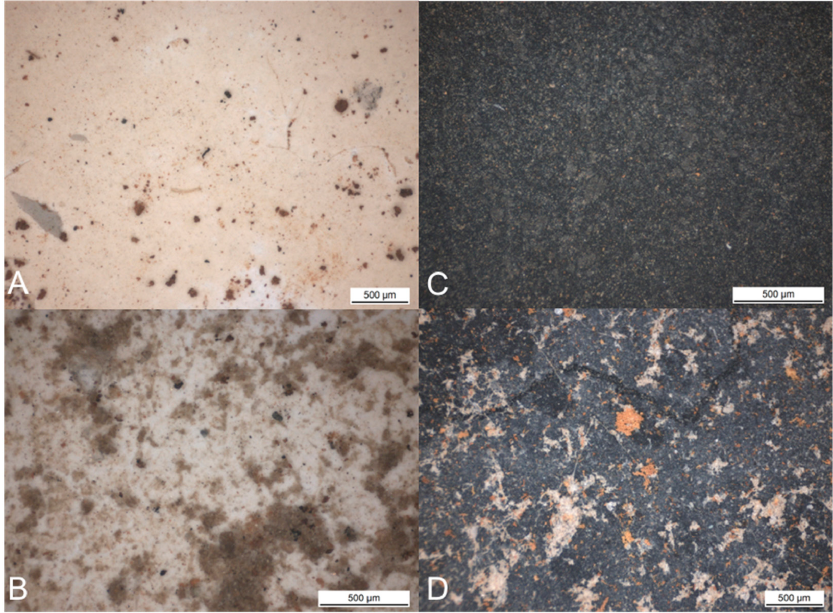
Figure 4. Fouling on surfaces of BioCleanEco coated specimens ( A , B ) and TeknoTar coated specimens ( C , D ), hypochlorite system ( A , C ) and control system ( B , D ).